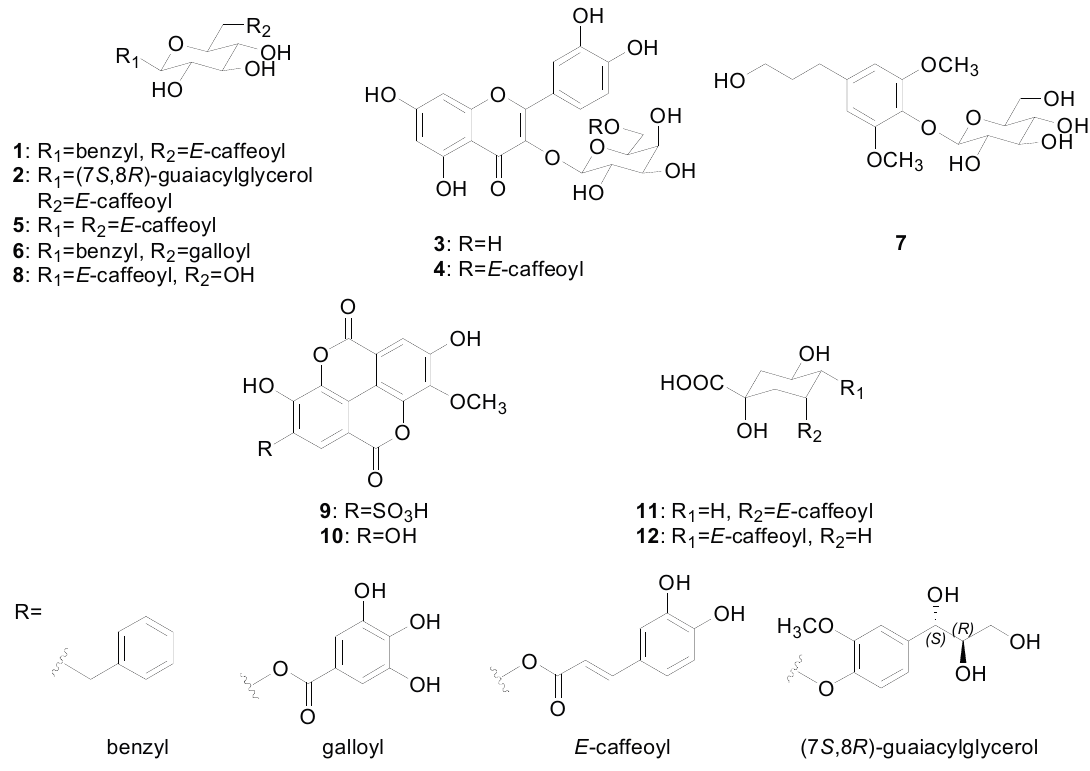
Figure 1. Chemical structures of Compounds 1 – 12 from L. speciosa.